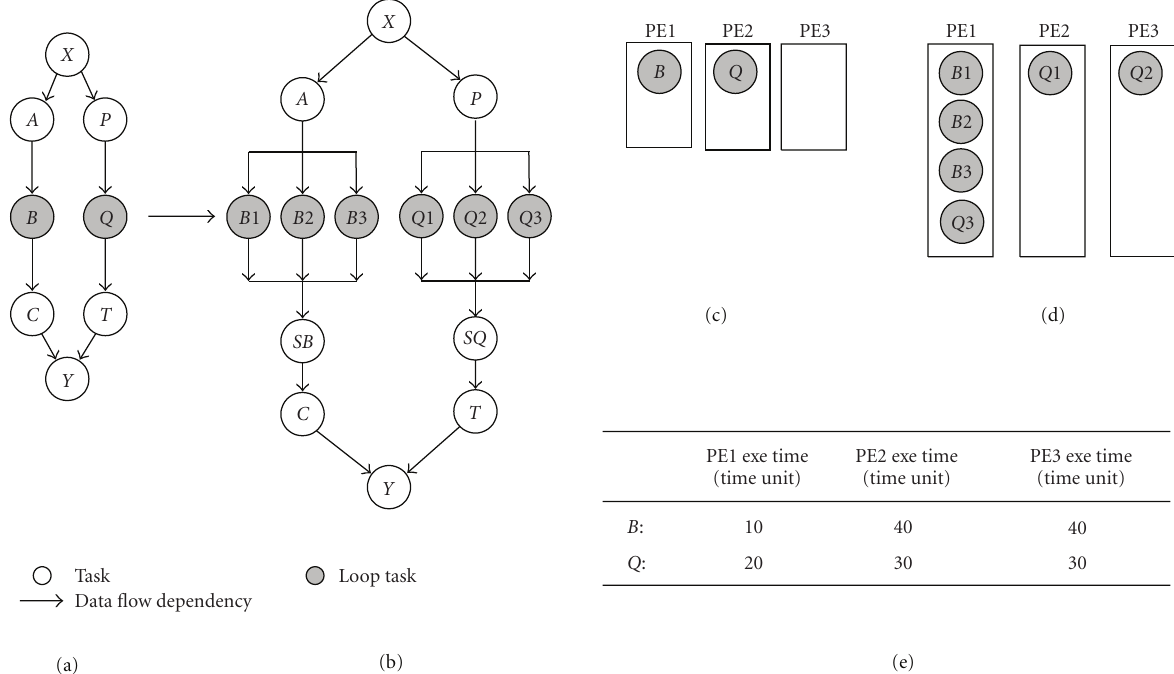
Figure 3: Mapping/scheduling example for loop unrolling and fission without data dependencies between iterations: (a) Task graph containing two parallel loops. (b) Task graph after unrolling the two loops for three iterations. (c) Mapping and scheduling solution before unrolling and fission, overall processing time for 3 iterations is 90 time units. (d) Mapping and scheduling solution after unrolling and fission, overall processing time is 50 time units. (e) Execution time of one iteration of the loop body for di ff erent processing elements. Higher interloop and intraloop parallelism are achieved by unrolling two